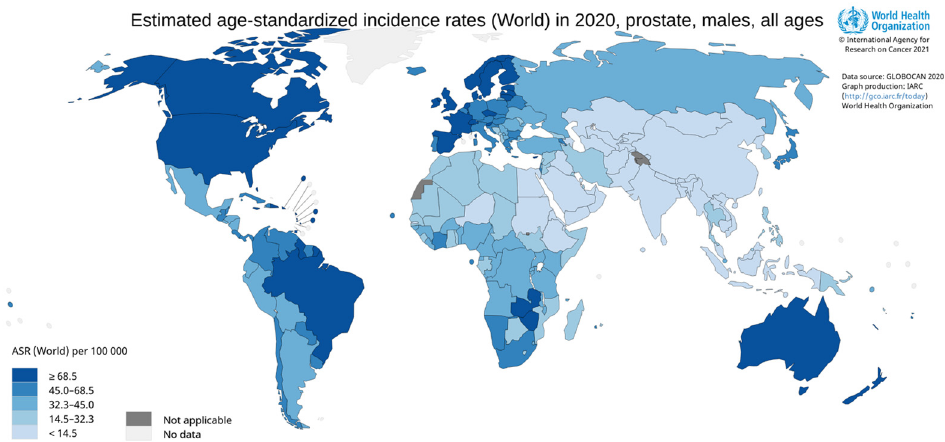
Figure 1. Word incidence rates of prostate cancer in 2020.